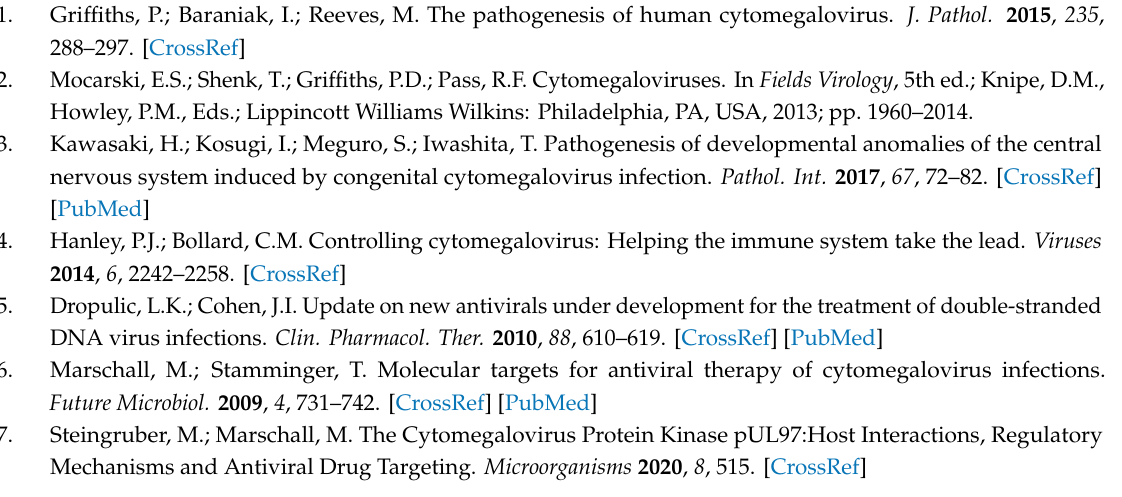
Figure S1. Video depiction of herpesviral 3D core NEC crystal structures: (a) HSV-1, (b) PRV, (c) HCMV and (d) EBV. Figure S2. Primary data of confocal imaging analysis comparing autologous versus nonautologous α - / β - / γ -herpesviral core NEC interactions. Table S1. Sequences of HCMV pUL53 and EBV BFLF2 hook